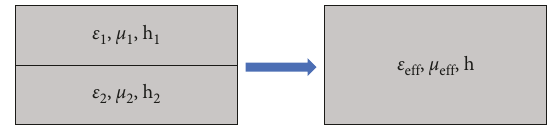
Figure 10: The double substrate and its equivalent single layer model.